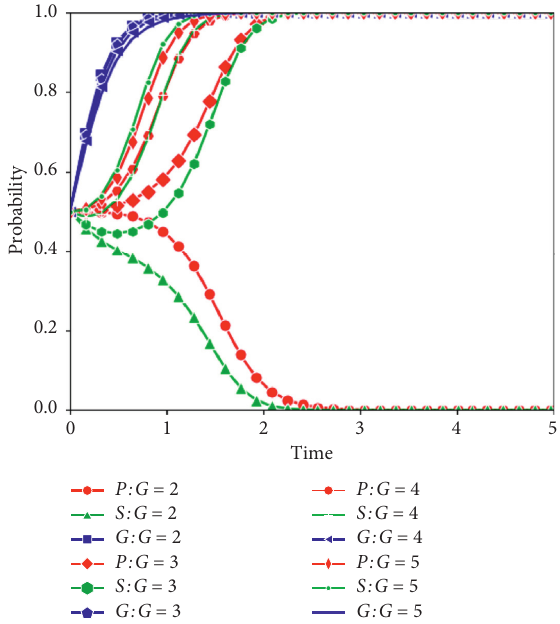
Figure 7: Dynamic evolution process of the tripartite game sub- jects when G changes.